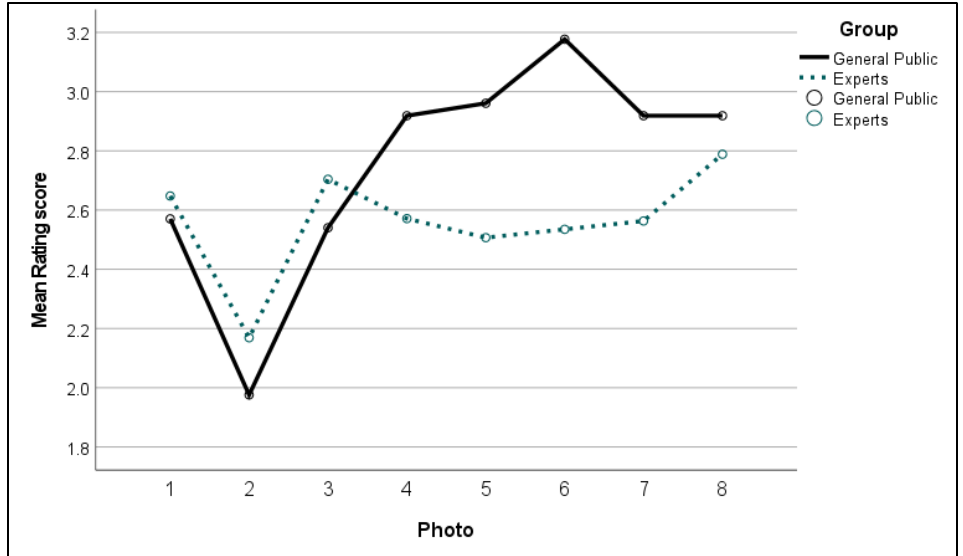
Figure 2. Mean rating scores of each context on the acceptance of visual aspects of WT moving parts.